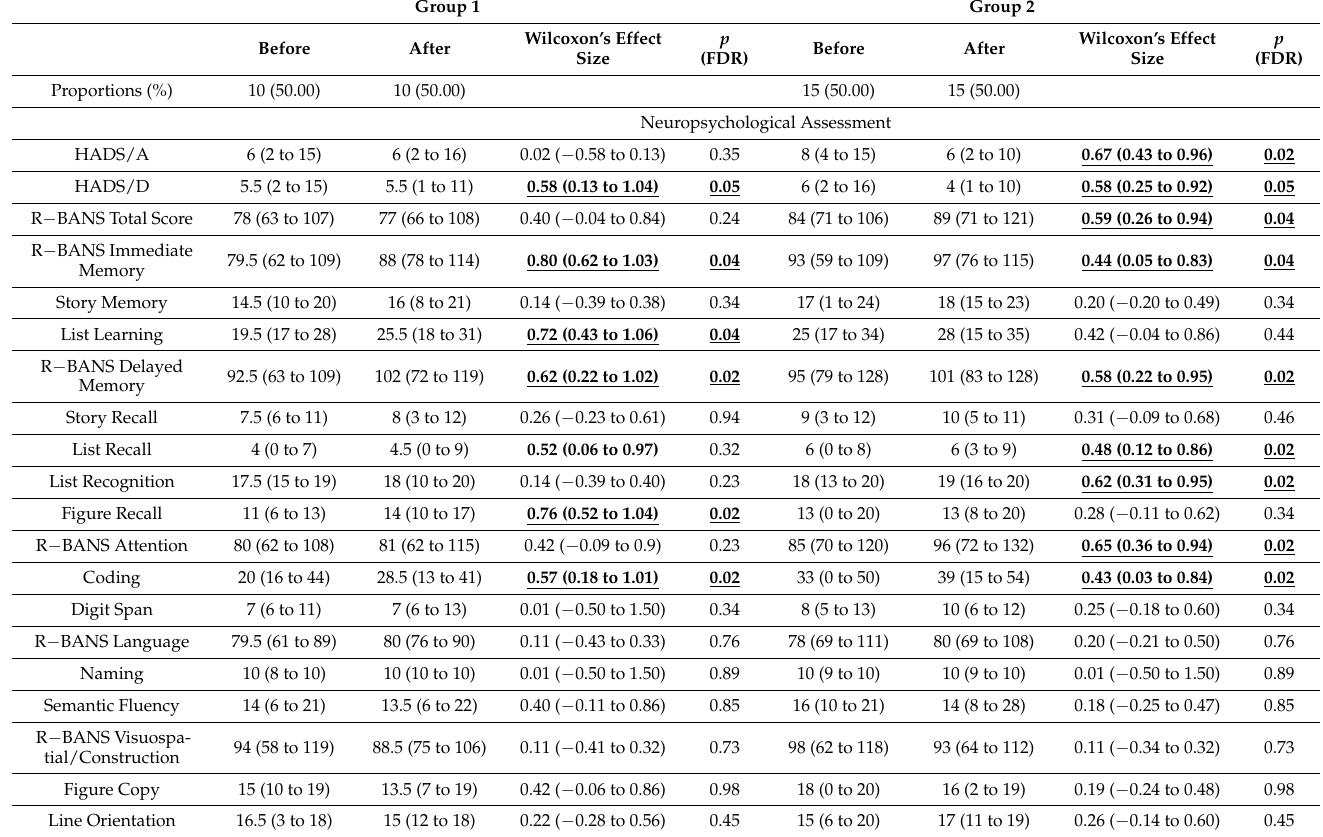
Table 3. Description of neuropsychological, pneumological, and motor assessments before and after treatment. n =